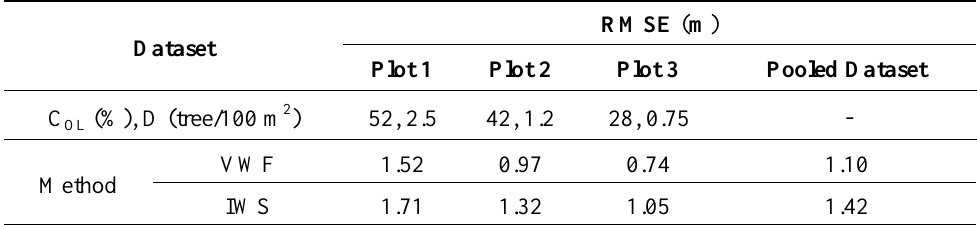
Table 6. Performances of the VWF and IWS methods in extracting tree positions from LiDAR data. RMSE ( m ) Dataset Plot 1 Plot 2 Plot 3 Pooled Dataset C (%), D (tree/100 m 2 ) 52, 2.5 42, 1.2 28, 0.75 - OL VWF 1.52 0.97 0.74 1.10 Method 1.71 1.32 1.05